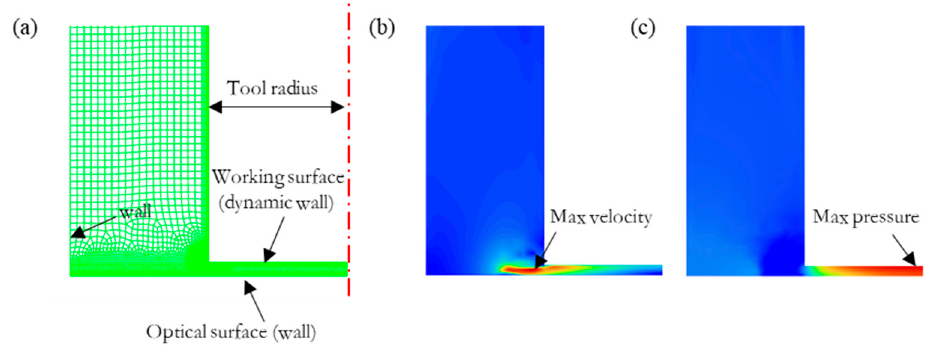
Figure 2. ( a ) FEA mesh model and the ( b ) velocity and ( c ) pressure distributions (gap = 0.25 mm, amplitude = 30 μ m).